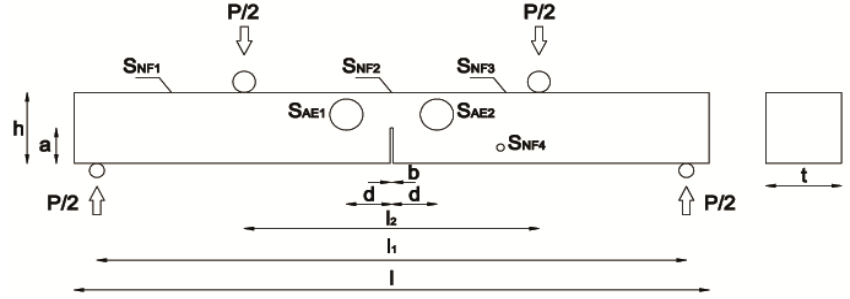
Figure 3. Specimen geometry and loading configuration. S AE1 and S AE2 are the sensors adopted to detect the AE signals, while S NF1 –S NF4 are the sensors used to reveal the natural frequencies. Table 1. Geometric dimensions of specimens (in mm).